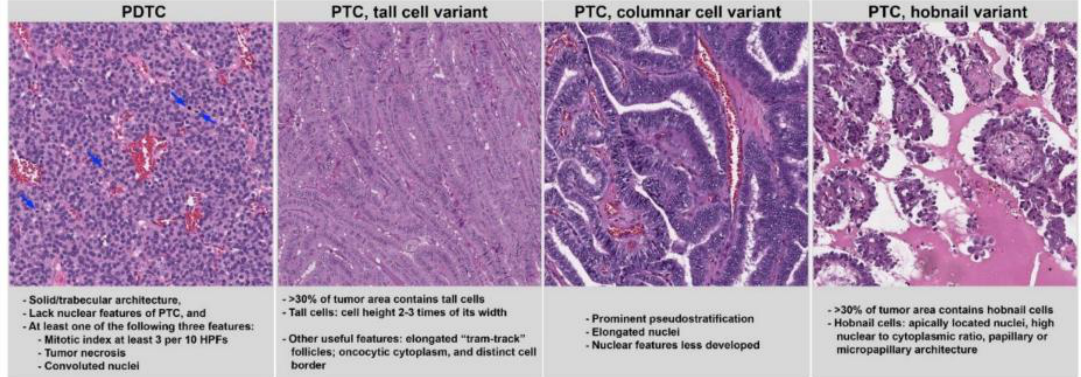
Figure 1. Histologic features and diagnostic criteria of aggressive types and variants of di ff erentiated thyroid carcinoma, including poorly di ff erentiated carcinoma (PDTC), papillary thyroid carcinoma (PTC) tall cell variant, columnar cell variant, and hobnail variant. The diagnostic features of each tumor are listed in the textbox below. HPFs: high power fields. Blue arrows: mitoses. Magnification: 100 ×